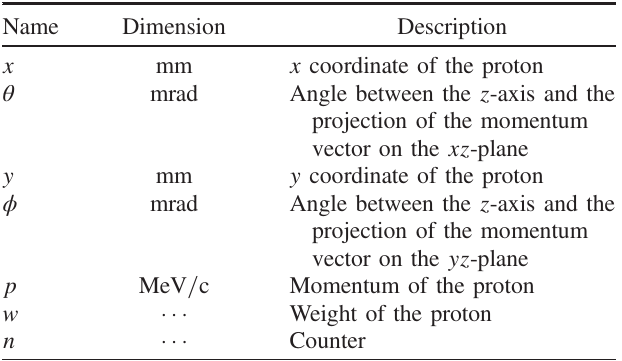
TABLE V. Tabulated parameters of the protons in the TURTLE output